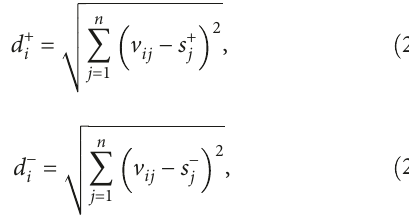
Algorithm 1 lists the procedure for determining